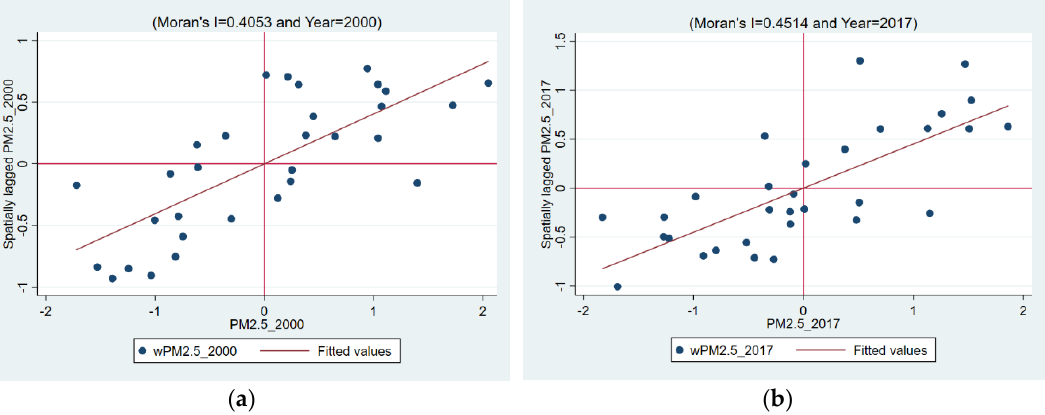
Figure 2. Local Moran scatter plot maps of China’s smog pollution. ( a ) Beginning of the investigation period; ( b ) end of the investigation period.